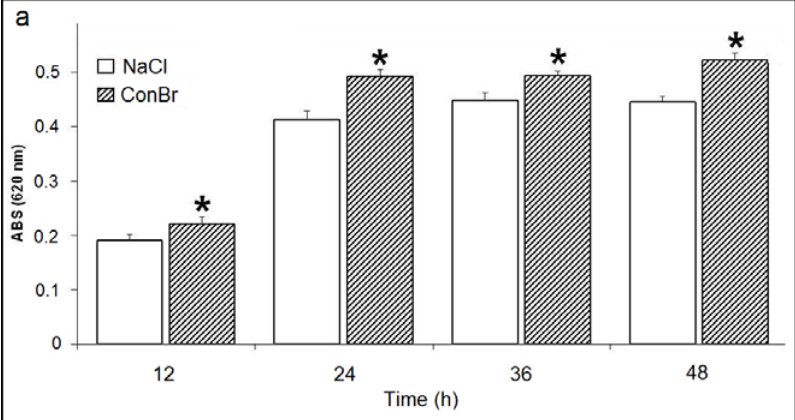
Figure 2. ( a ) Effect of ConBr on the growth of R. tropici . (  ) p < 0.01 related to 0.15 M NaCl; ( b ) Comparison between the effects of ConBr and ConBr complexed with D -mannose on the growth of R. tropici . (  ) p < 0.01 related to ConBr plus D